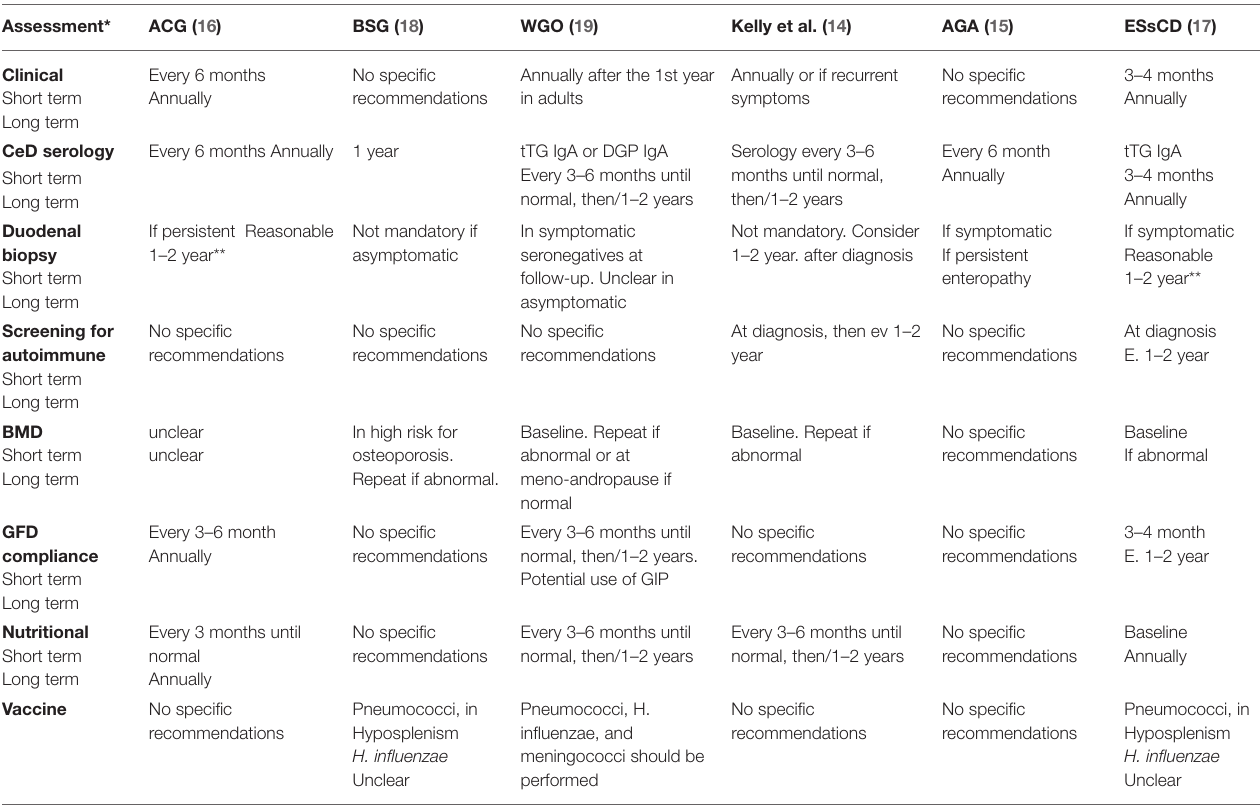
TABLE 1 | Comparison of guidelines recommendations for follow up of adult patients with